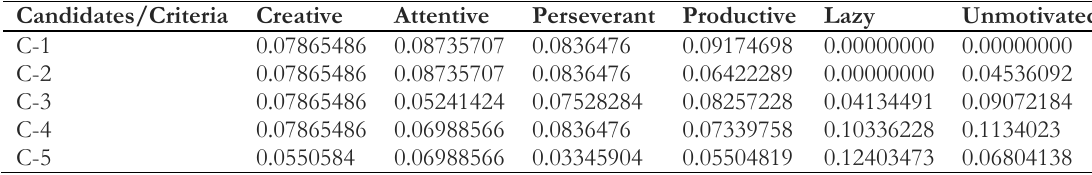
Table 10. Results of the weighted normalized decision matrix.